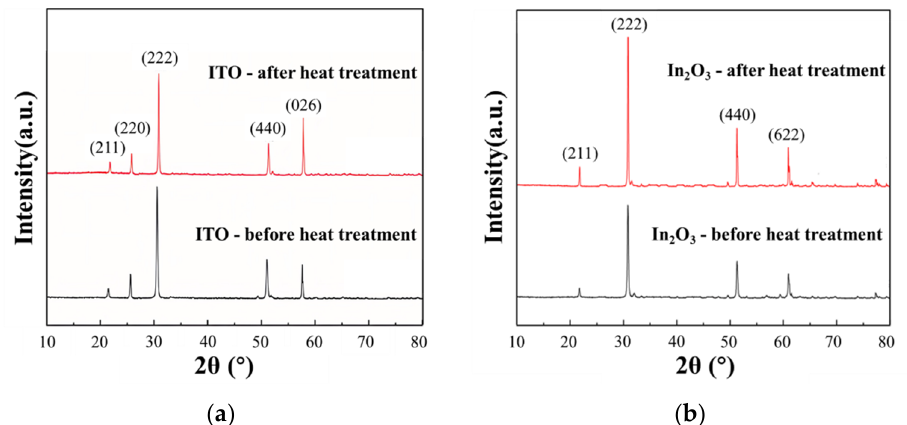
Figure 9. XRD diffraction patterns of the ( a ) ITO and ( b ) In 2 O 3 thin films before and after the heat treatment.